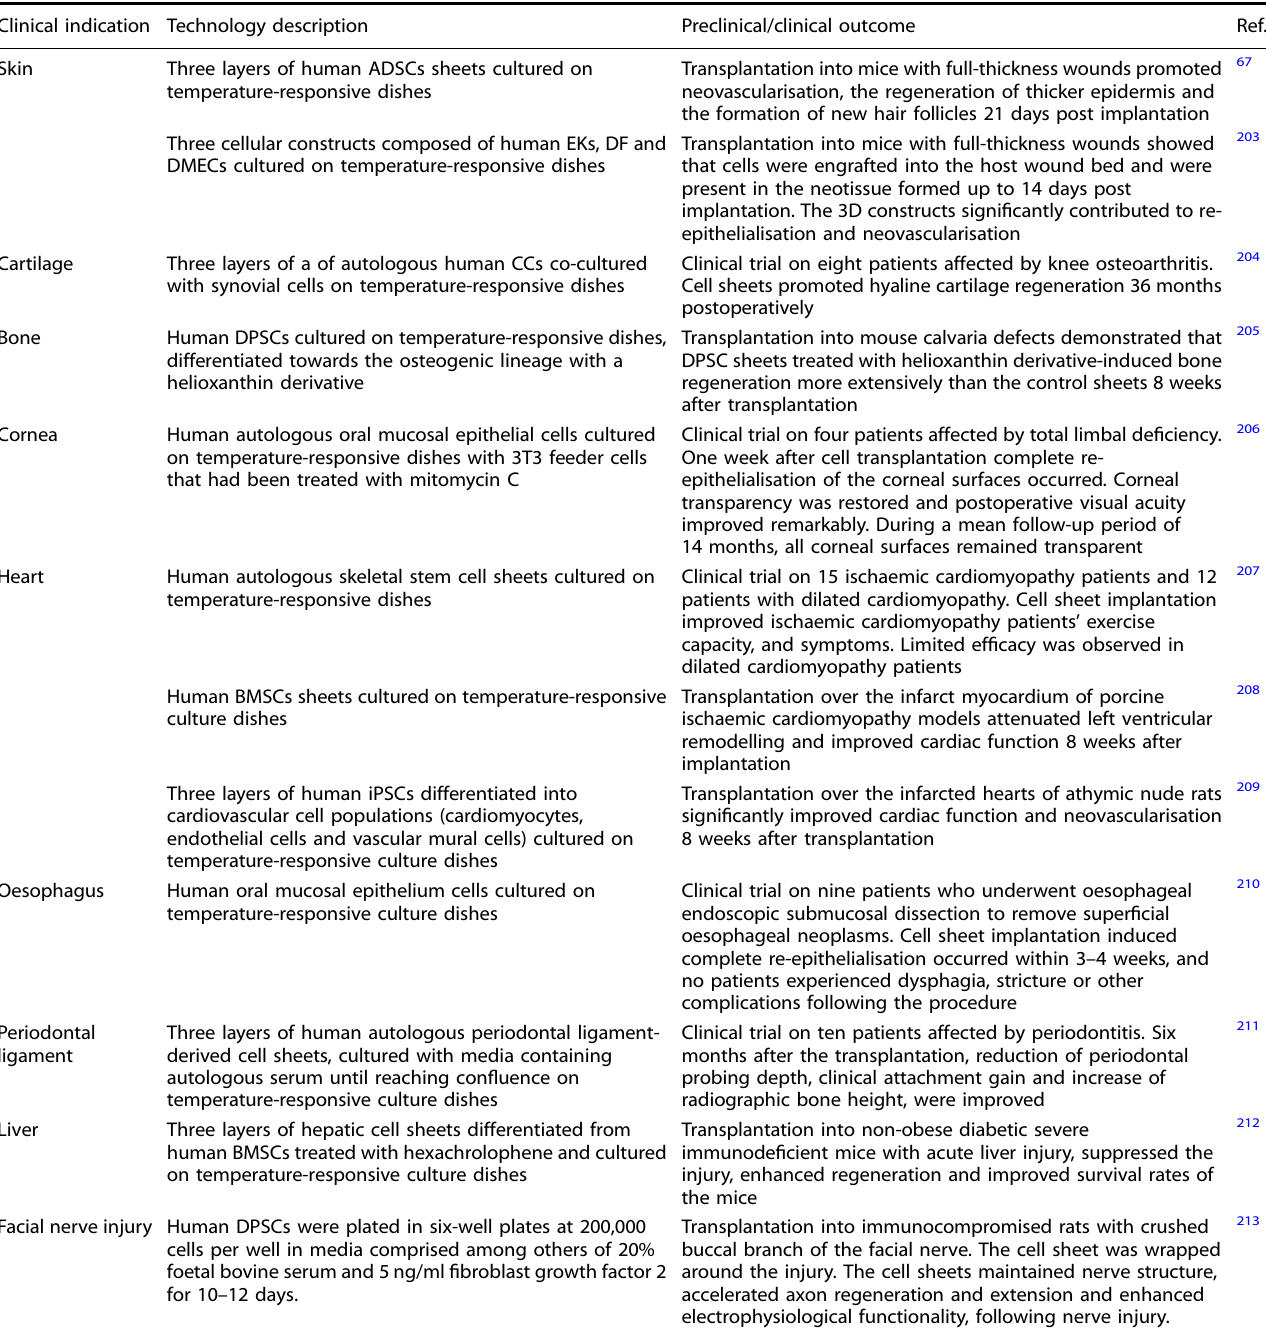
construct (Table 5). For example 104,000 cells/cm 2 human